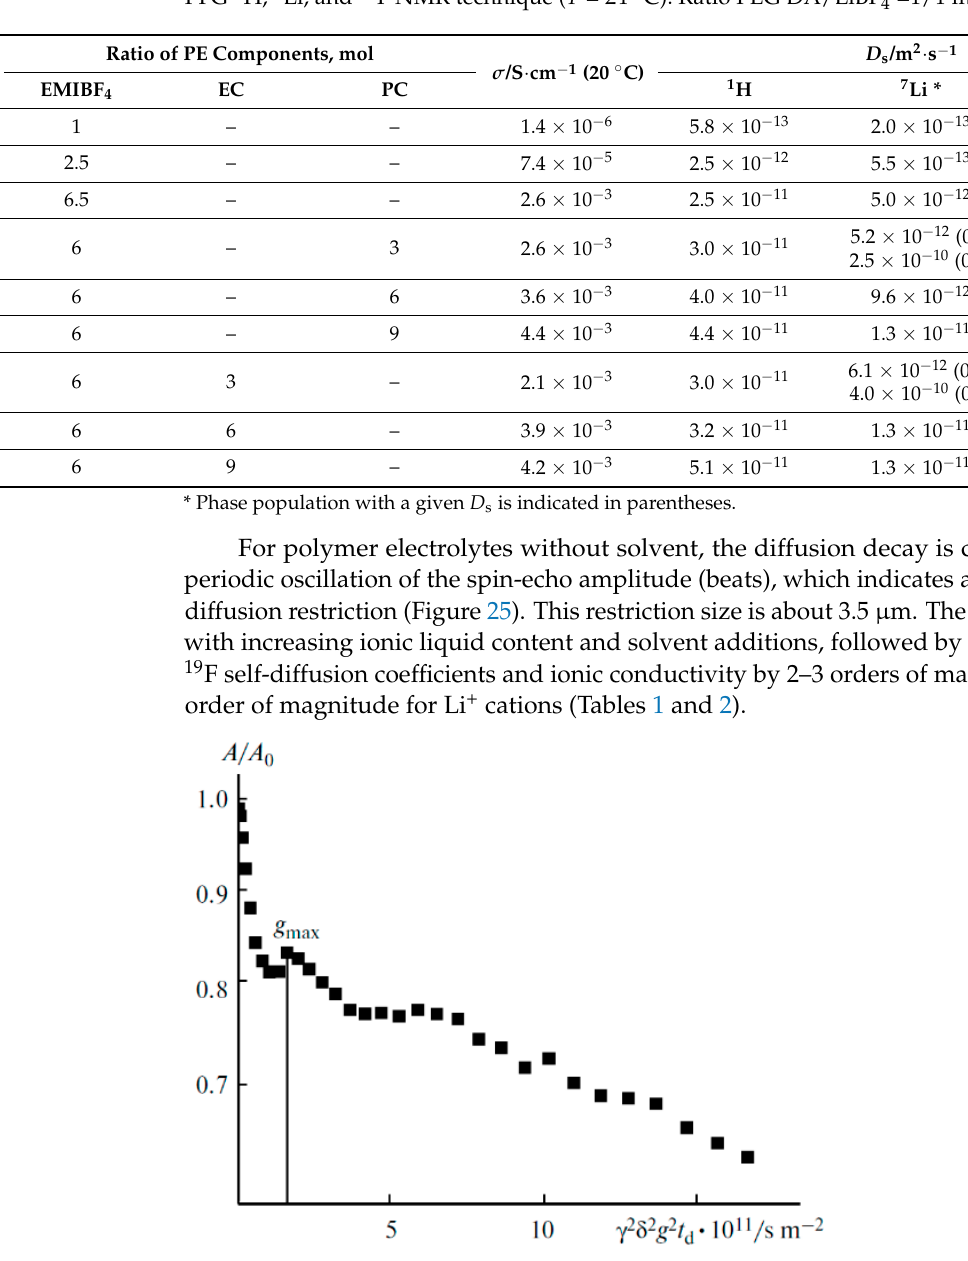
Table 8. Compositions, conductivity ( σ ), and self-diffusion coefficients ( D s ) of PE measured by the